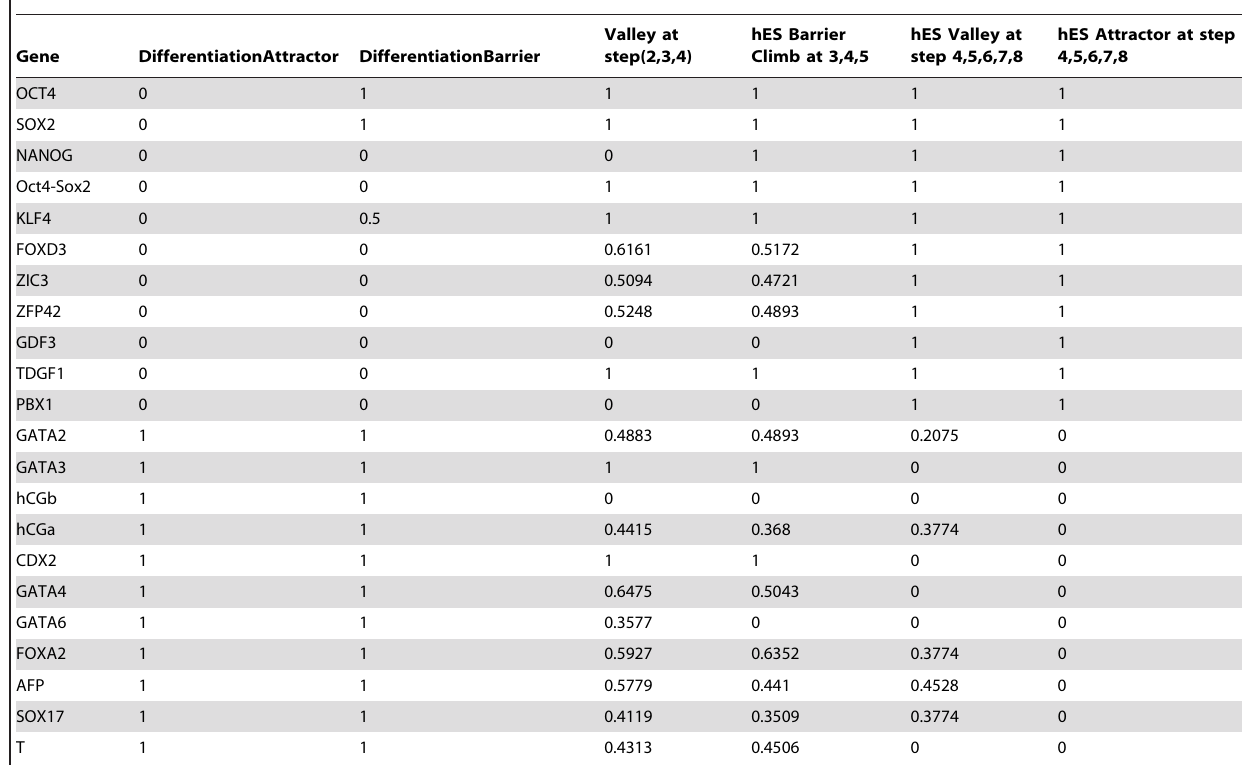
Table 5. Transition states (expression levels) during reprogramming using the five experimental recipes.